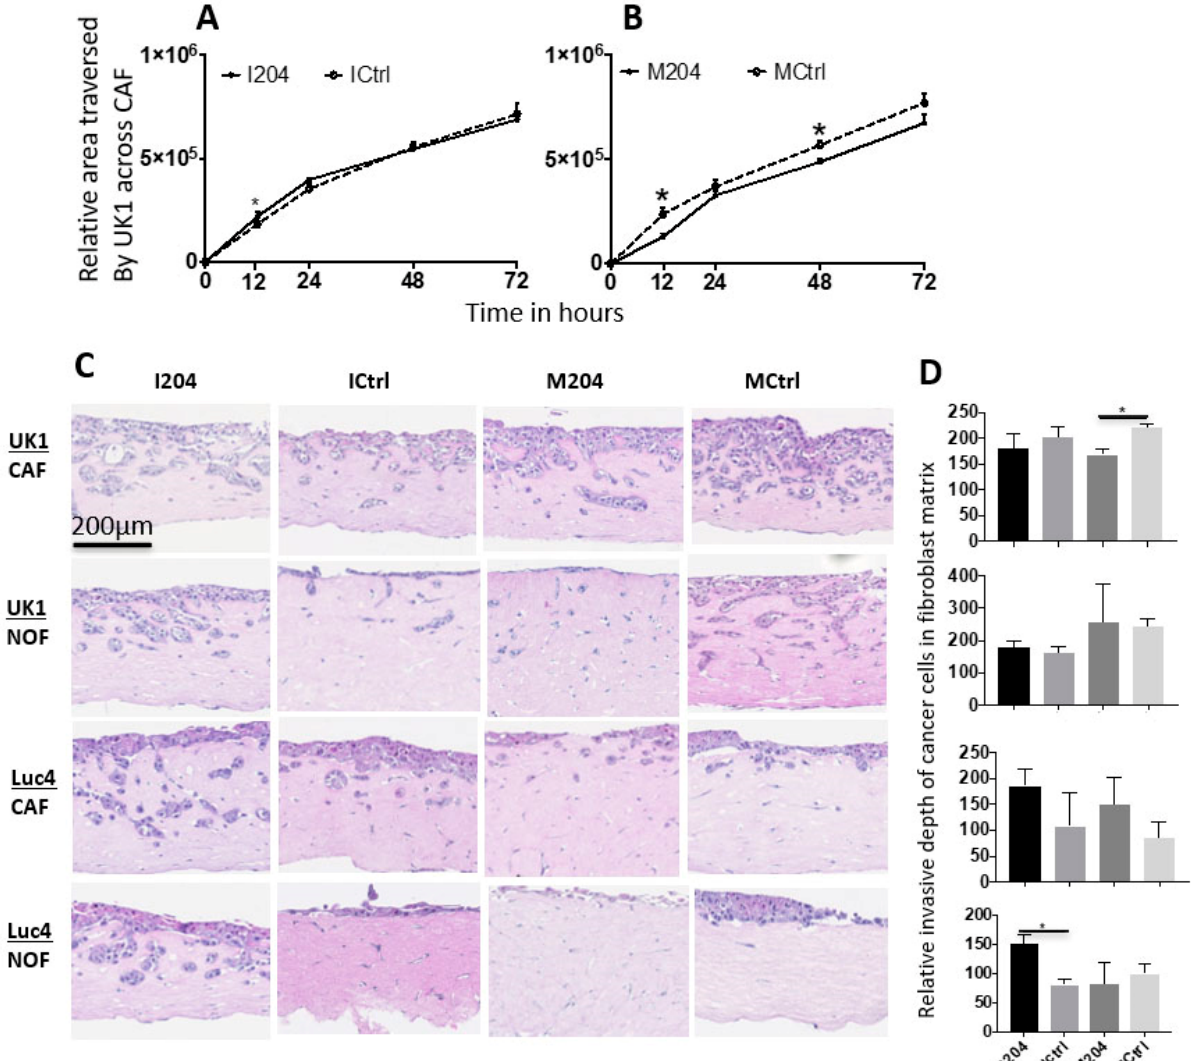
Figure 6. ( A , B ) Graphs showing quantification of the area traversed by UK1 across the gap towards CAFs at different time points from the baseline post miR-204 modulation in CAFs in UK1-CAF monolayer co-culture ( n = 4). ( C ) Representative pictures from 3D organotypic cultures showing the invasion by OSCC cell lines UK1 and Luc4 in post miR-204 modulated fibroblasts-populated collagen matrices and ( D ) the corresponding graphs depicting the quantification of invasion depths ( n = 4, unpaired t -test, * p < 0.05).